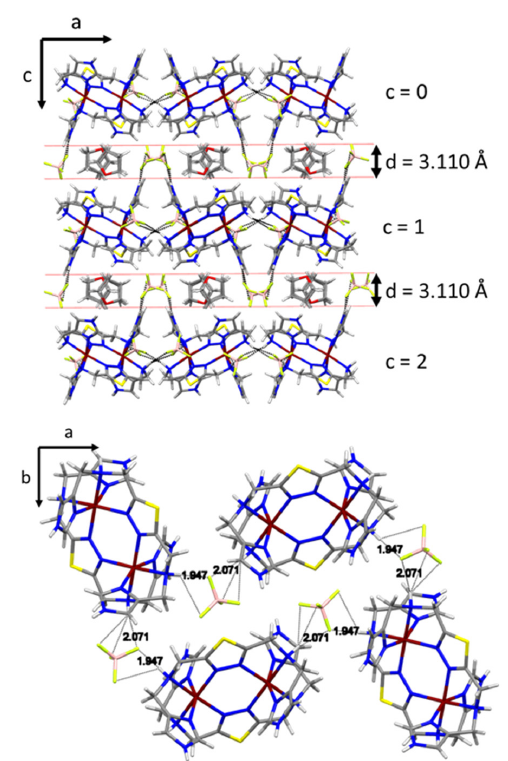
Figure 4. Crystal packing and hydrogen bonding (black dashed lines) toward neighboring anions in C3 ·THF at 200 K (space group Pbca ). Top. View along the crystallographic b -axis. Bottom. View along the crystallographic c -axis. Solvent molecules, as well as non-bridging counterions, have been omitted for clarity. Color code: Fe dark red, N blue, S yellow, C gray, B pink, F green and H white. For C1 and C2 , the dinuclear complex cations show hydrogen bonding between the amino or the imidazolyl groups and the respective counter anions triflate or perchlorate (Figures S8 and S10). While for C1 , a three-dimensional network is realized for C2 intertwined layers are formed. In both compensate for bond lengths and volume changes that come together with a spin transition. Thus, single-crystal structure analysis reveals that it is very unlikely that C1 and C2 show any SCO behavior.